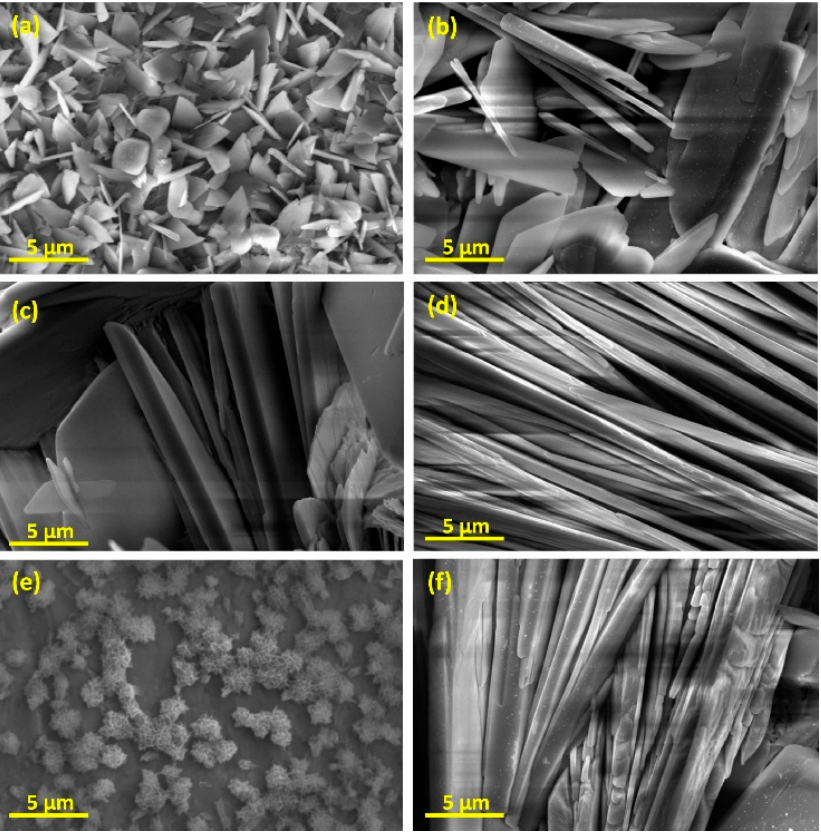
Figure 8. SEM micrographs of HA-coated samples by electrodeposition at ( a ) 1 V, ( b ) 2 V, ( c ) 3 V, ( d , e ) 5 mA / cm 2 and ( f ) 10 mA / cm 2 [122].